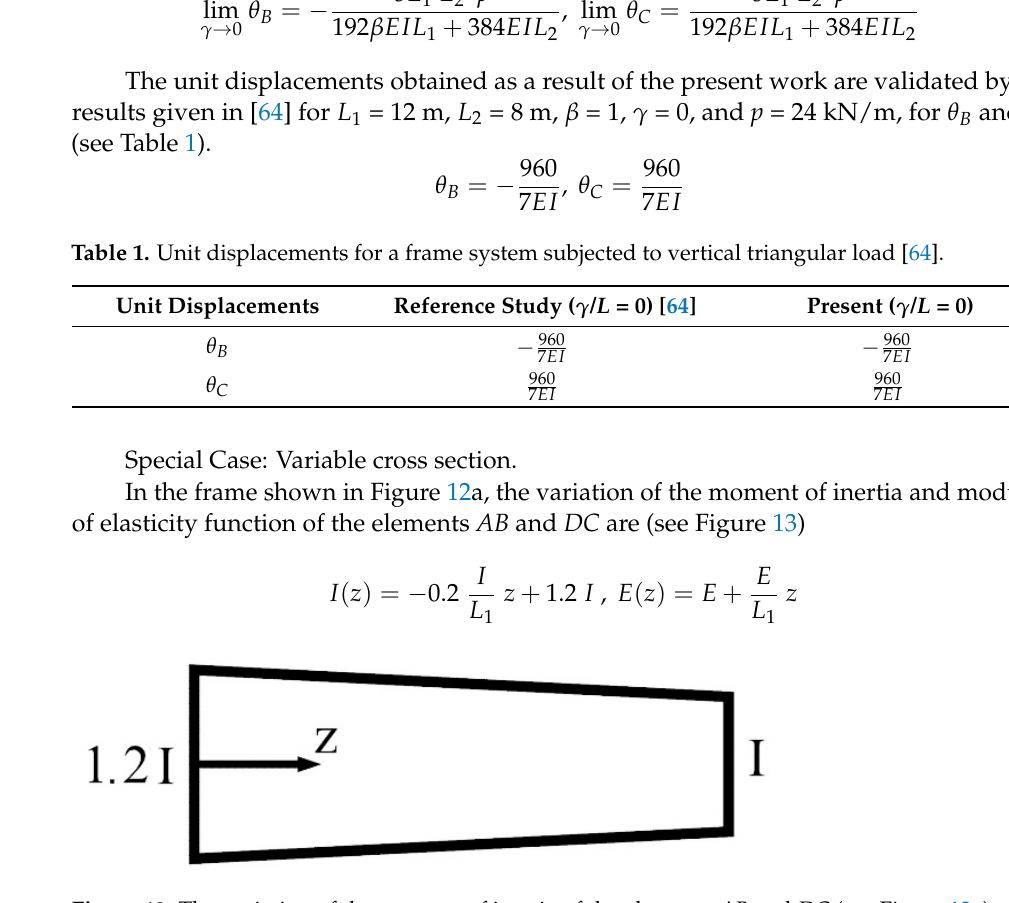
Table 1. Unit displacements for a frame system subjected to vertical triangular load [64].